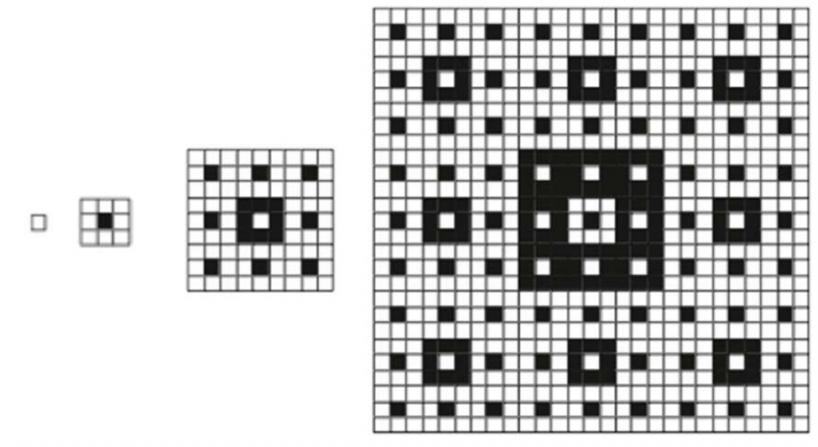
Figure 2. Gaskets.